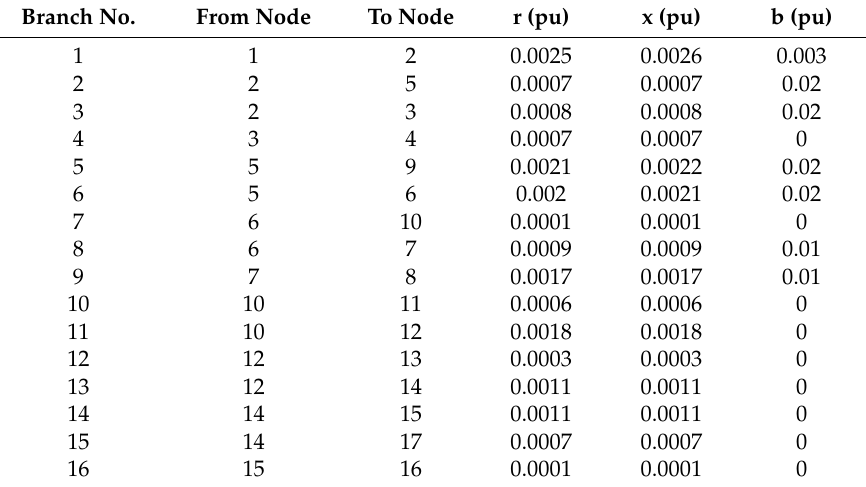
Table 1. Distribution overhead line